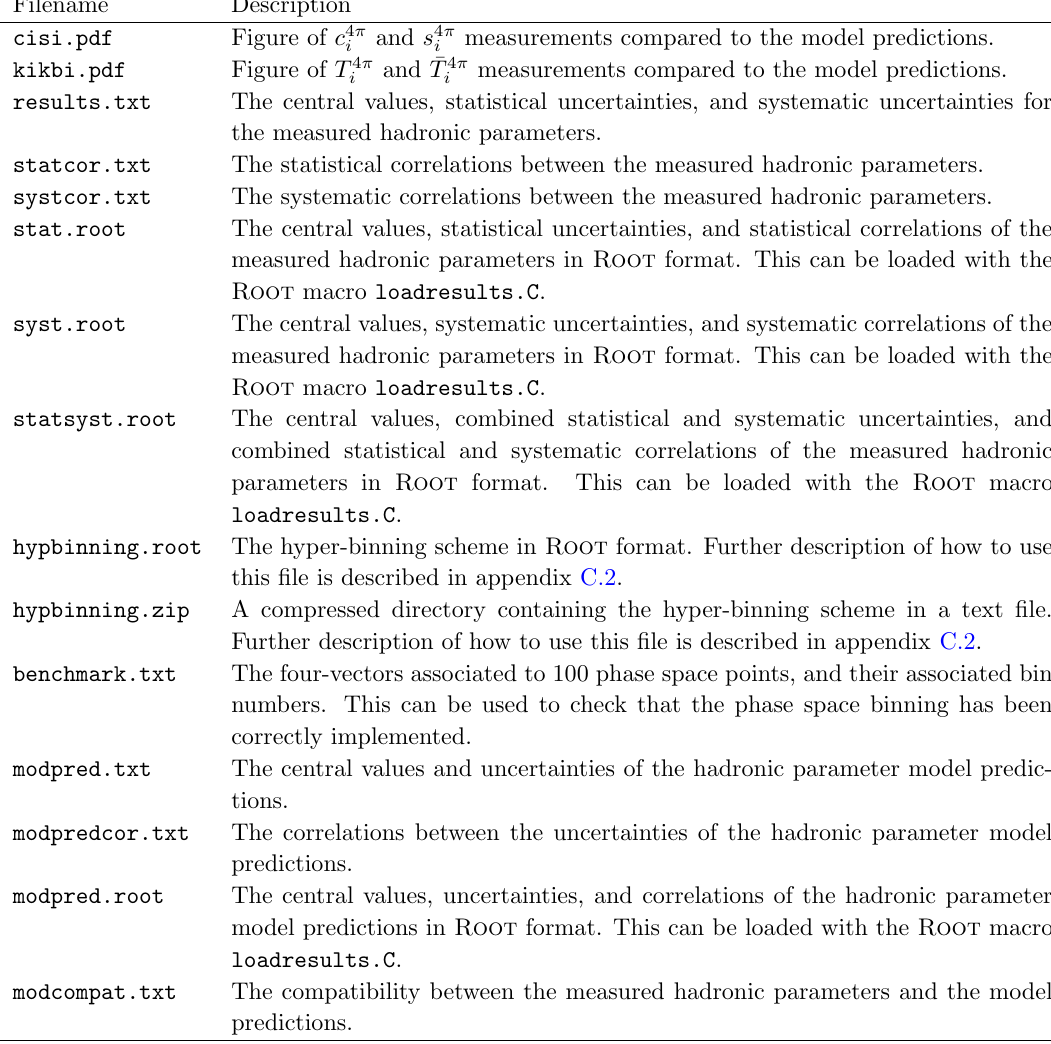
Table 14 . List of (cid:12)les in the supplementary material that are used to describe the measured hadronic parameters for a particular phase space binning